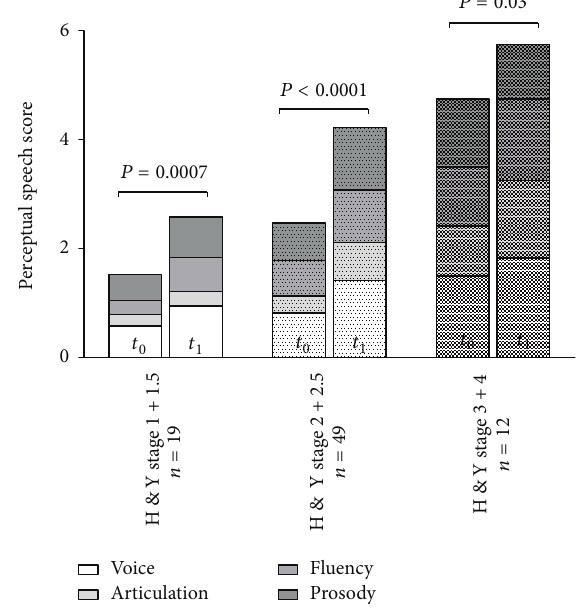
Figure 1: Average values of the perceptual speech scores at baseline (left column) and at followup (right column), subdivided according to the stage of disease.